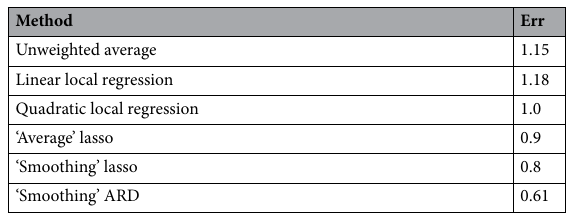
Table 2. Test errors over all stations and all non-eclipse days for the methods discussed in this paper. Since we perform ARD only for a subset of times out of t • , we restrict all errors to this subset. The ARD error is the posterior standard deviation averaged over times and stations. The other errors are computed to be comparable with this, as the RMSE over days in d ◦ , averaged over times and stations.